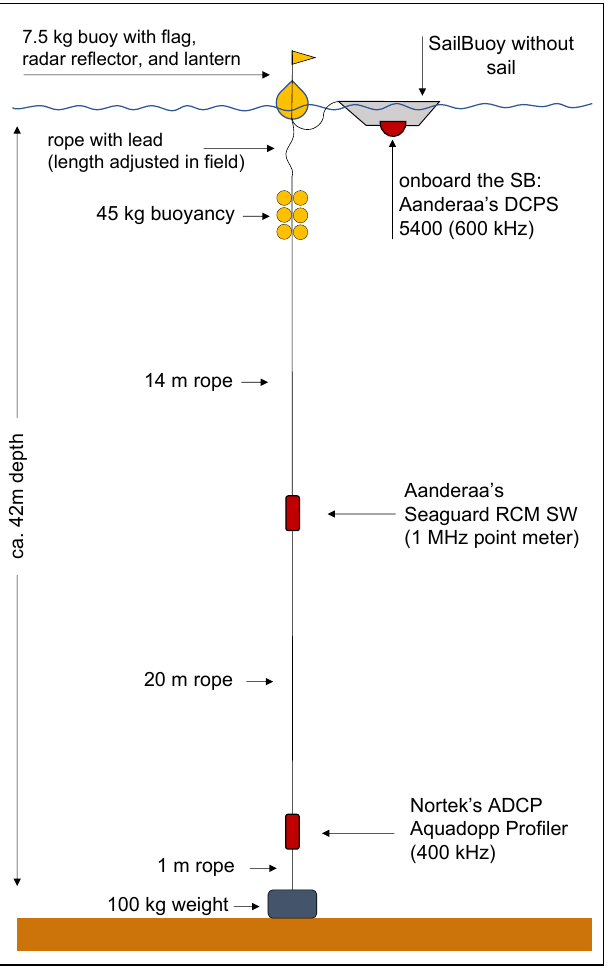
Figure 2. Schematic drawing of the instrumental setup of the stationary validation experiment in Fusafjorden in